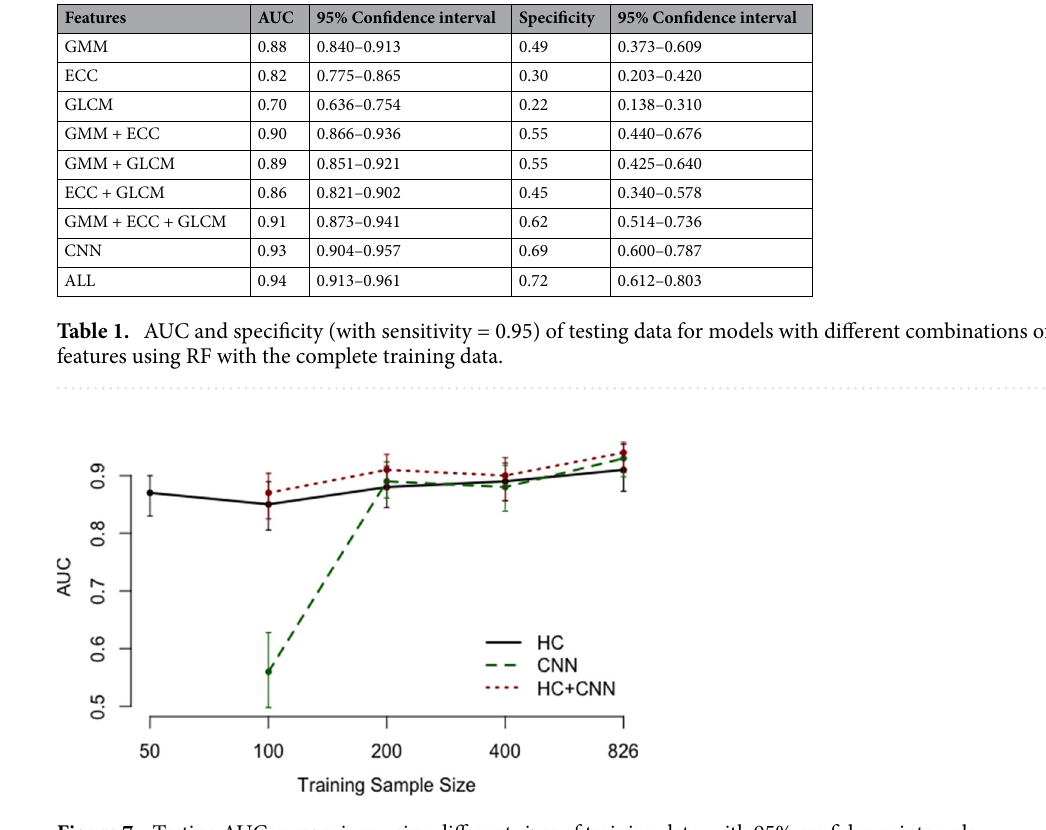
Figure 7. Testing AUC comparison using different sizes of training data, with 95% confidence